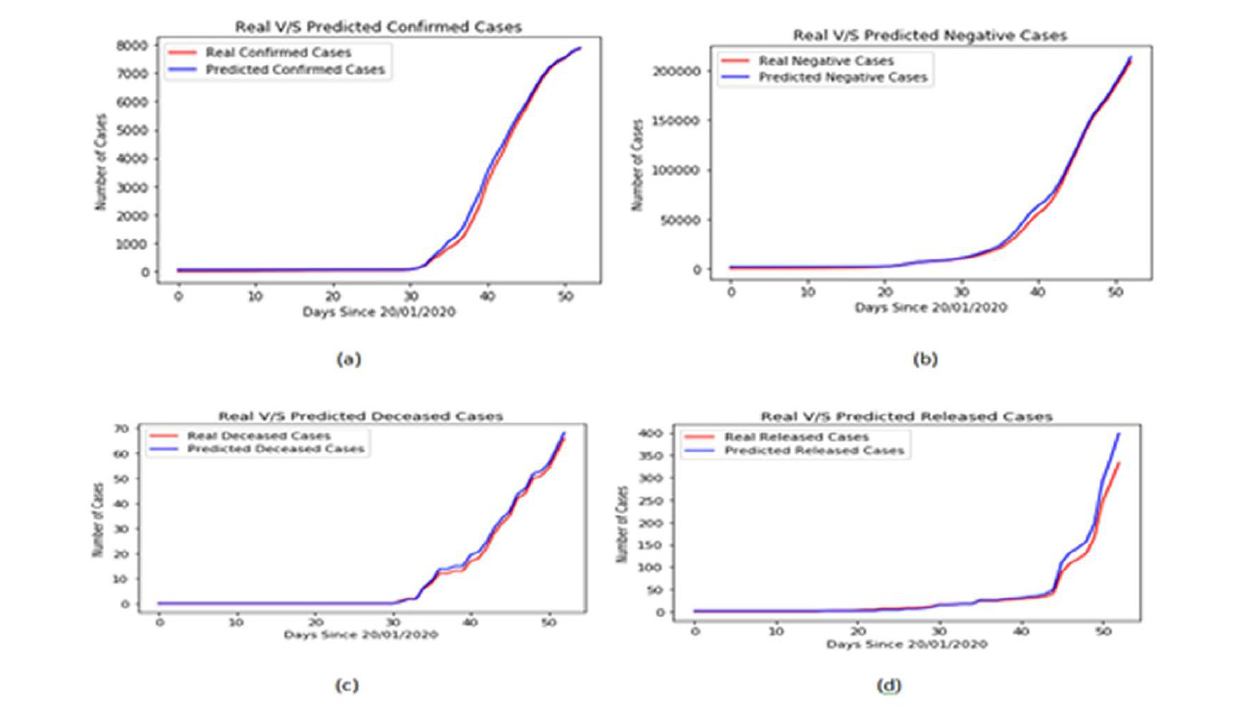
Figure 6: Real V/S Predicted Cases using LSTM-GRU RNN model for (a) Confirmed Cases (b) Negative Cases (c) Deceased Cases (d) Released